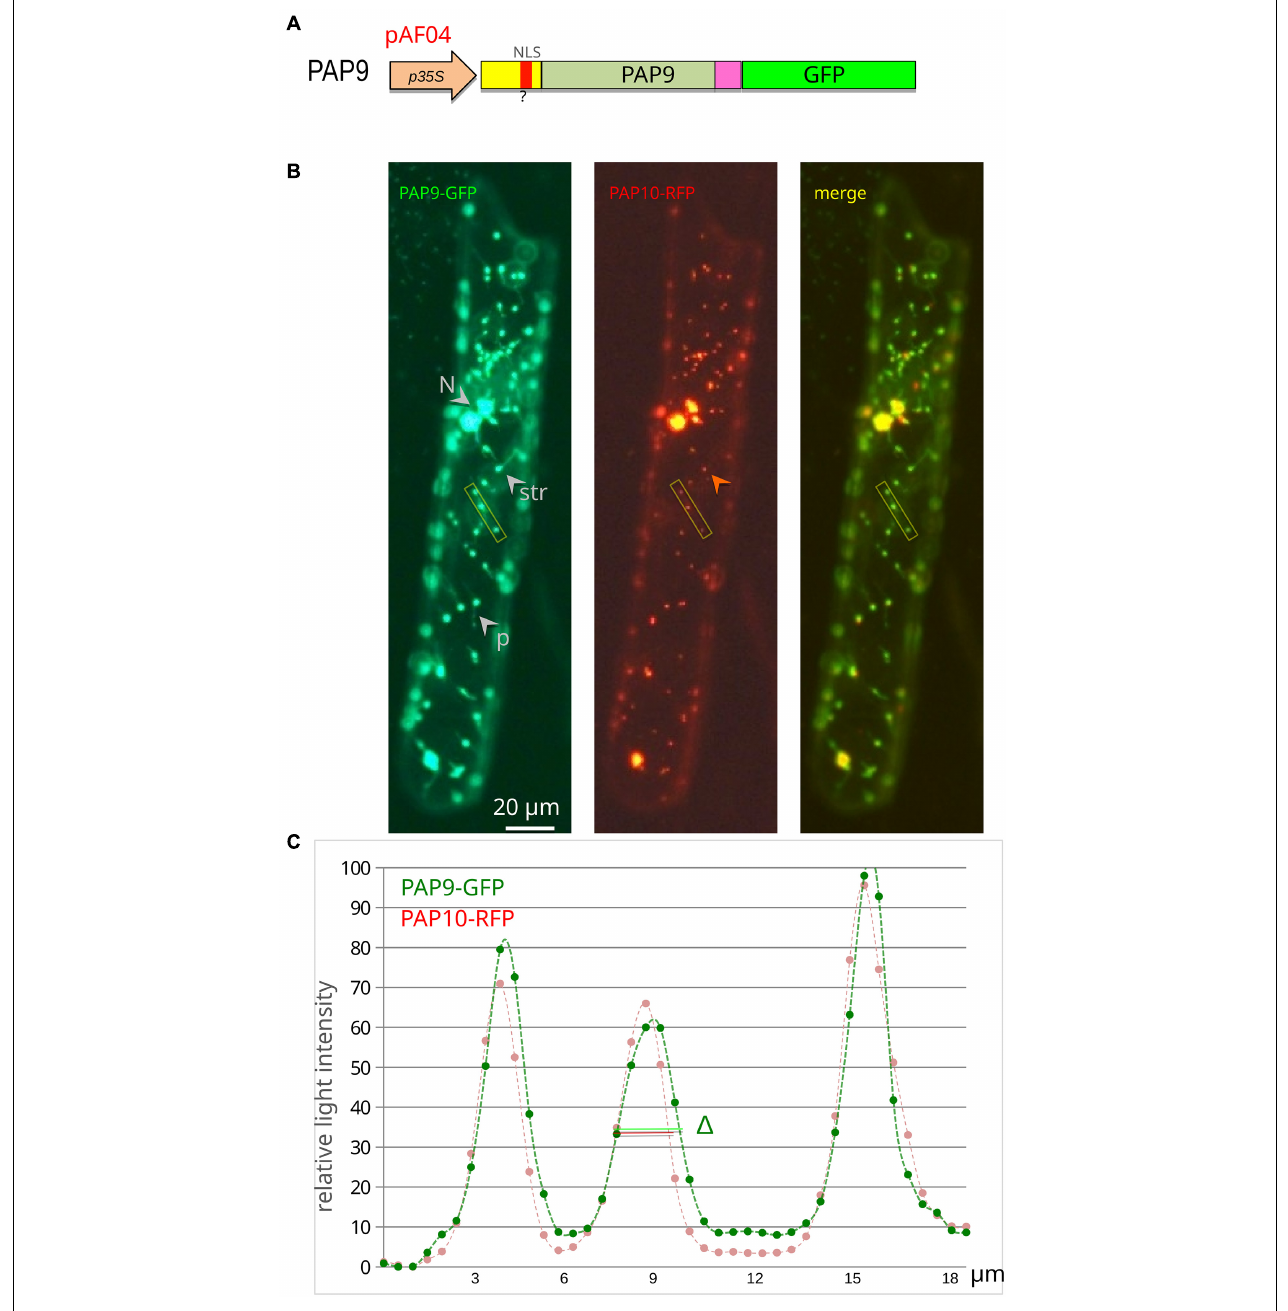
FIGURE 3 | PAP9 is localized in plastids. (A) Schematic illustration of the PAP9-GFP construction in pAF04. p35S, CaMV35S promoter region; cTP, chloroplast transit peptide in yellow; ?, predicted NLS (nuclear localization signal) in red; C-terminal domain in magenta; GFP in green. (B) Transiently expressed PAP9-GFP in onion epidermal cells. N, nucleus; str, stromule; p, plastid. The red arrowhead points to the absence of red fluorescence in stromules. The yellow rectangle represents the analyzed segment in panel (C) . (C) Fluorescent signal quantitative profile on an 18- µ m-long segment of the image across three plastids. (cid:49) represents the difference in width of the GFP signal compared to the red signal of